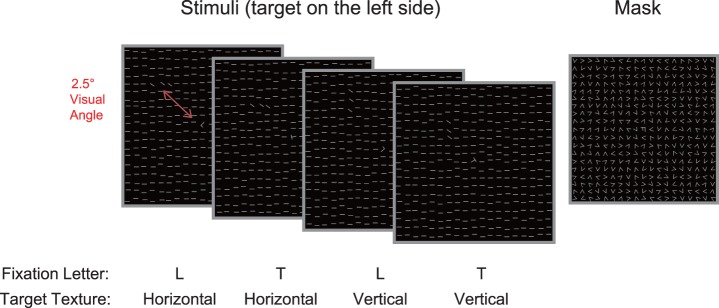
Experimental stimuli displays.The texture stimulus (left) was composed of three adjacent diagonal bars (vertically or horizontally aligned) embedded within a background of horizontal bars, with a letter “T” or “L” as the fixation. The mask (right) was made of randomly oriented “V”, with superimposed “T” and “L” at the fixation position.